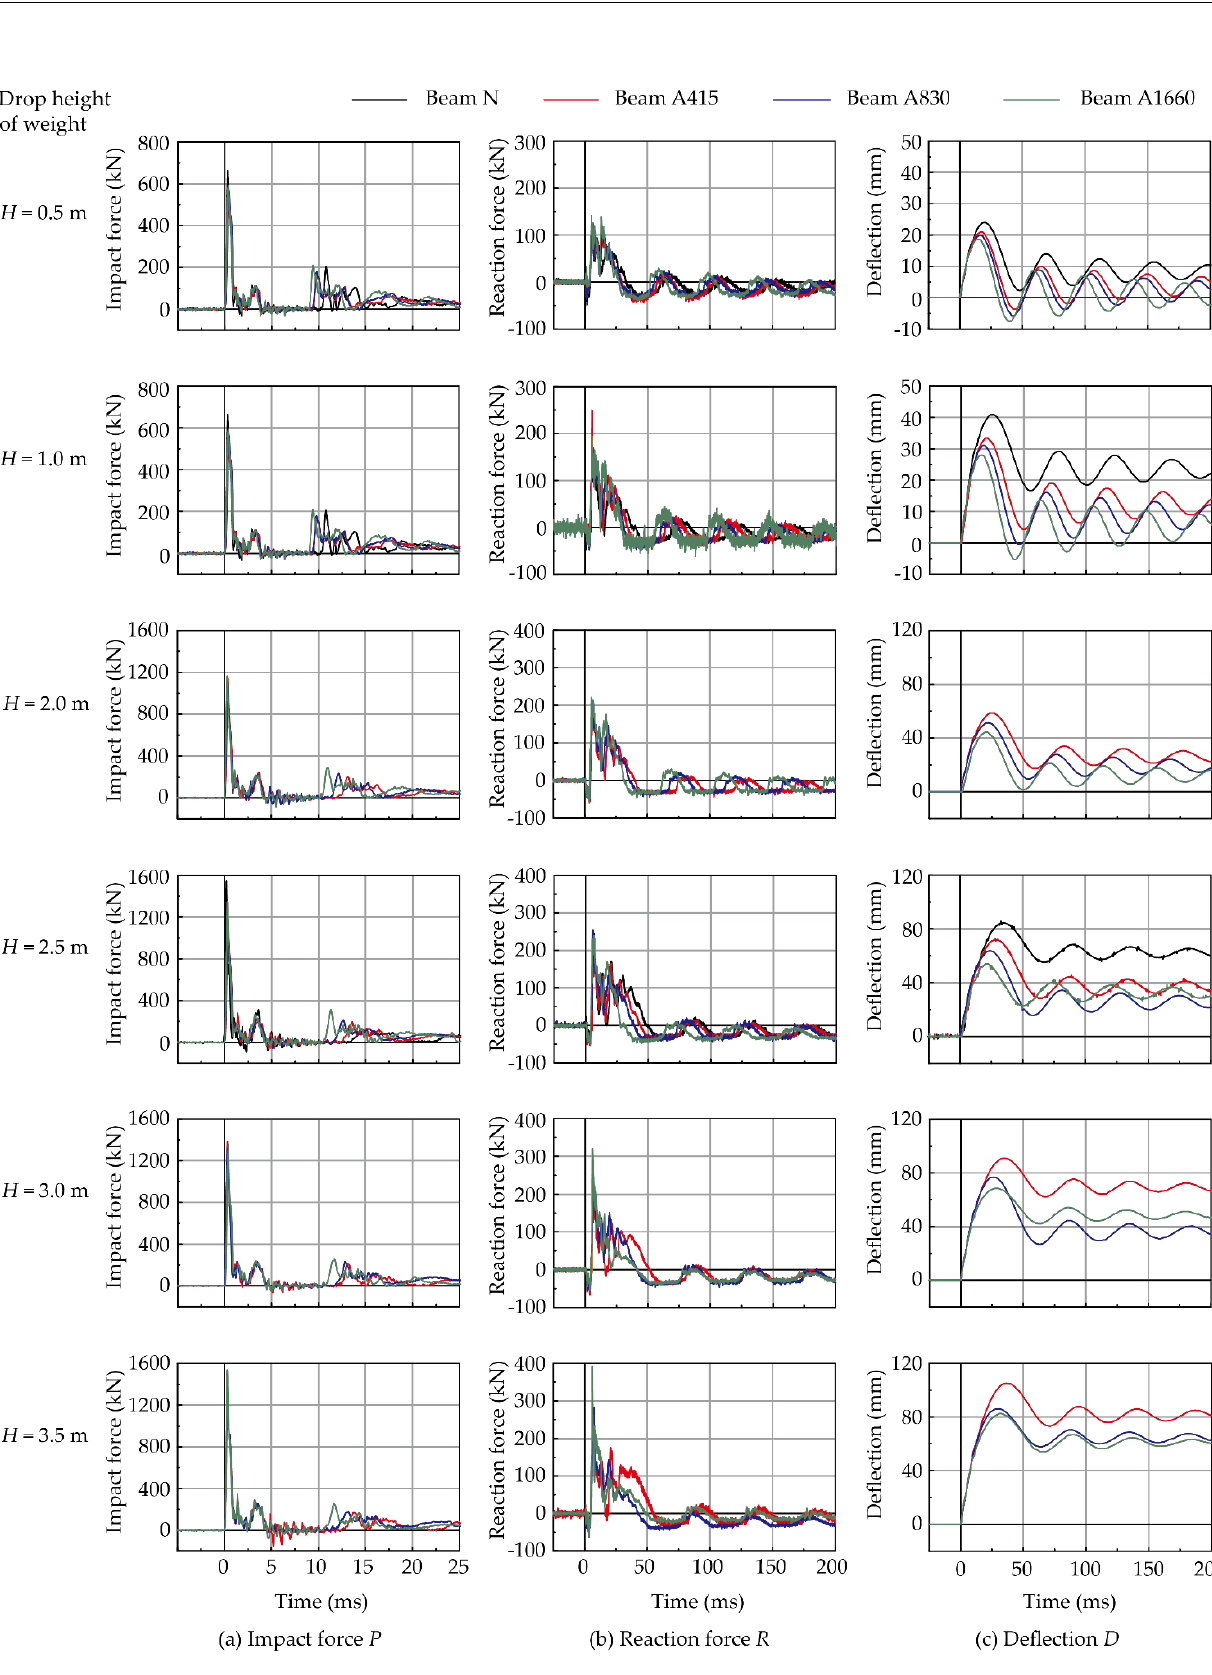
Figure 12. Time history of the dynamic responses of the beams.